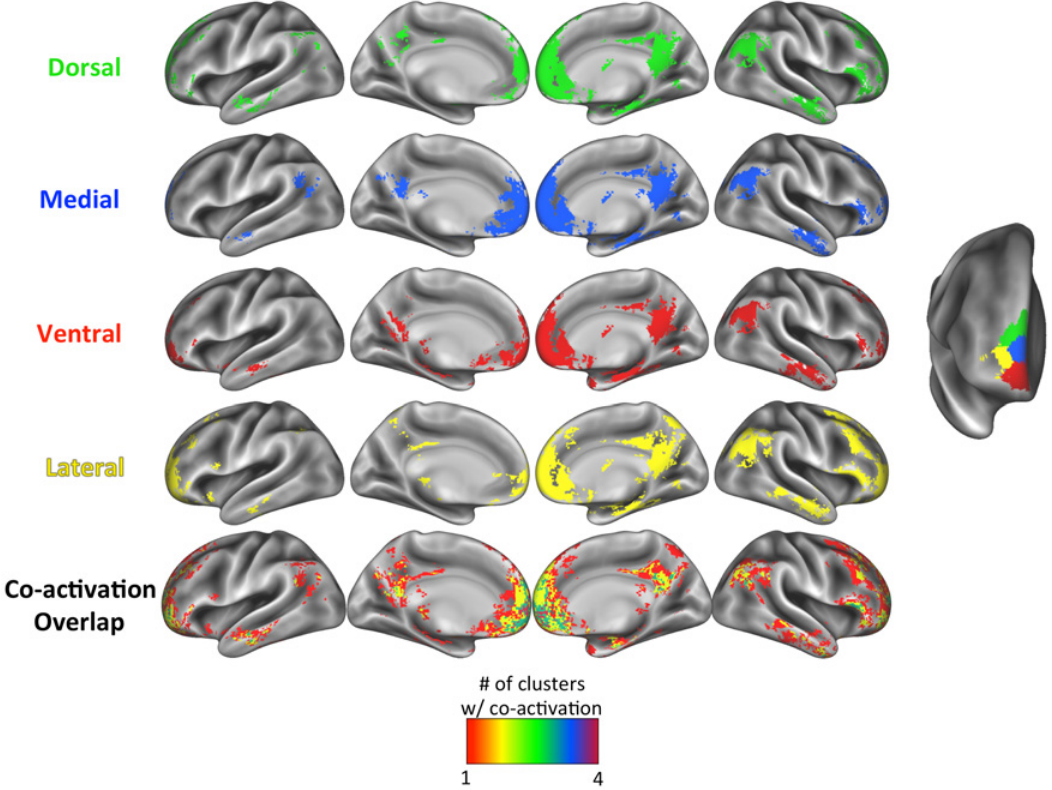
Fig 11. Meta-analytic functional co-activation maps for each cluster of the right K = 4 solution. The colors match the cluster labels in Fig 2 ( K = 4), reproduced on the right. The degree of overlap in the co-activation maps in shown in the bottom row, with the color scale for the overlap shown at the bottom of the